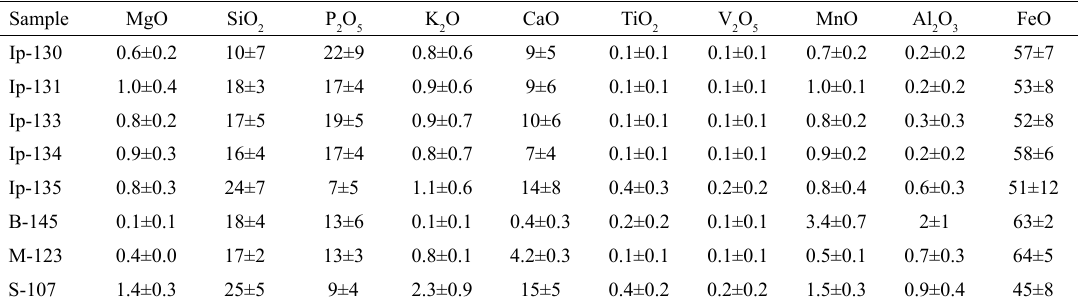
Figure 2: Typical bivariate graphs showing the amount of oxides in the “entire” multiphase slag inclusions: (a) %SiO (b) %CaO versus %K Table 3: Average EDX microanalysis results of the matrix of the slag inclusions Sample